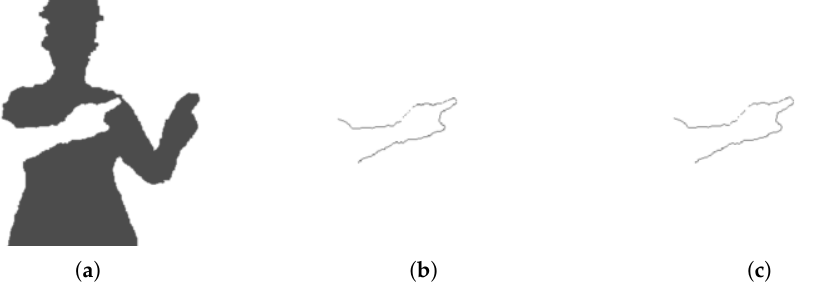
Figure 4. Relevant binary images. ( a ) F other is the set of foreground pixels outside the arm segment (in this case, the right arm). ( b ) B inner is the set of pixels inside the arm and neighbouring F other . ( c ) B outer is the set of pixels inside F other and neighbouring the